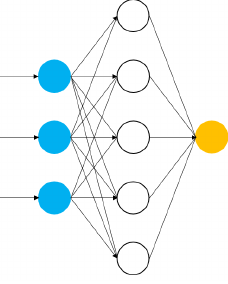
Figure 1. Basic architecture of an ANN. It is composed of edges and neural units arranged using an input layer (blue neural units), a hidden layer (white neural units), and an output layer (yellow neural